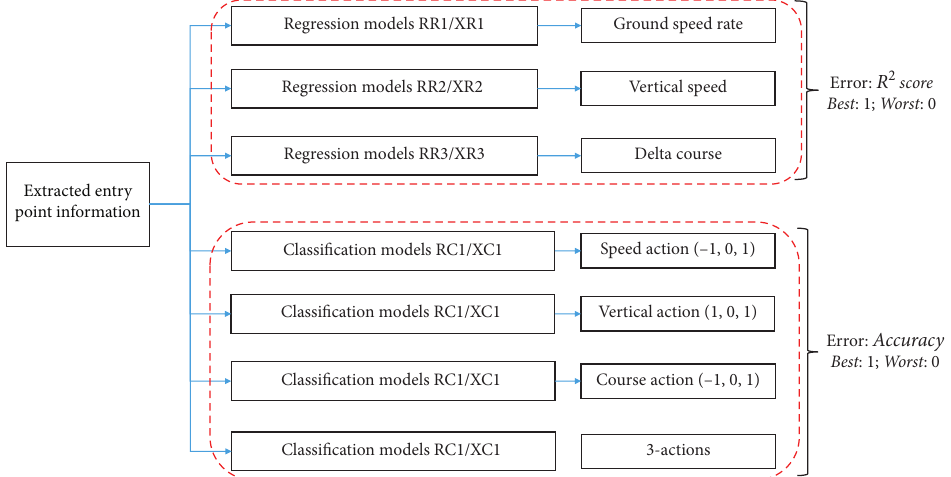
Figure 13: Illustration of developed predictive models: regression models of Random Forest (RR) and XGBoost (XR) and classification models of Random Forest (RC) and XGBoost (XC). R 2 score is used as metric for regression models, while Accuracy is the metric for classification